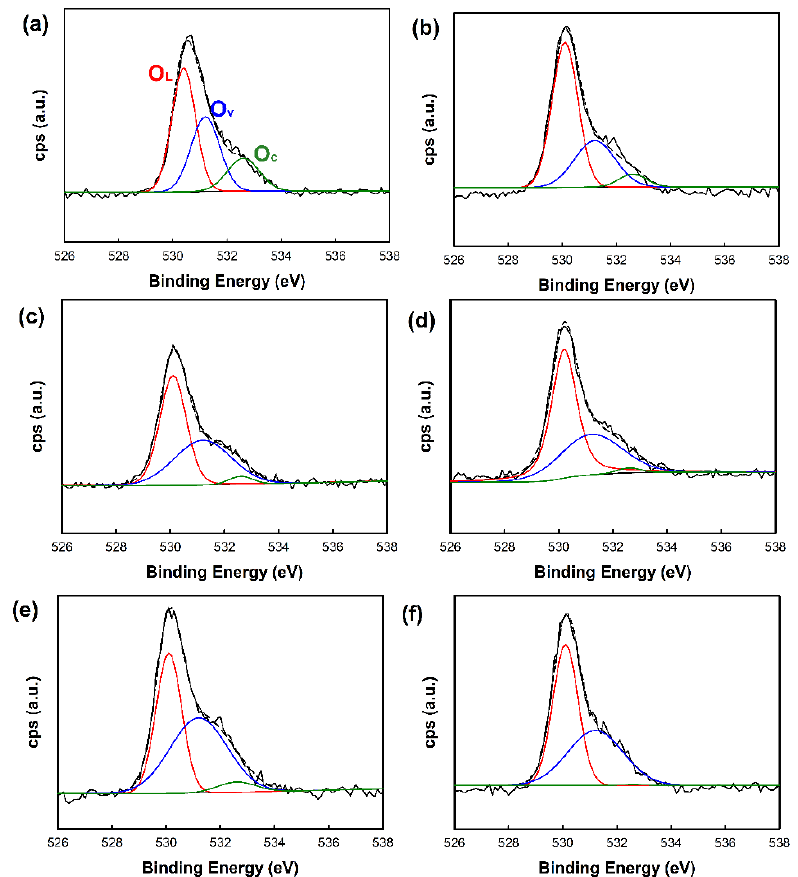
Figure 8. XPS O1s spectra of the ZnO nanostructures and metal-deposited ZnO nanostructures: ( a ) ZnO nanorod, ( b ) ZnO nanoplate, ( c ) Au / ZnO nanorod, ( d ) Au / ZnO nanoplate, ( e ) Cu / ZnO nanorod, and ( f ) Cu / ZnO nanoplate. Table 5. Surface oxygen components in ZnO nanostructures and metal-deposited ZnO nanostructures.